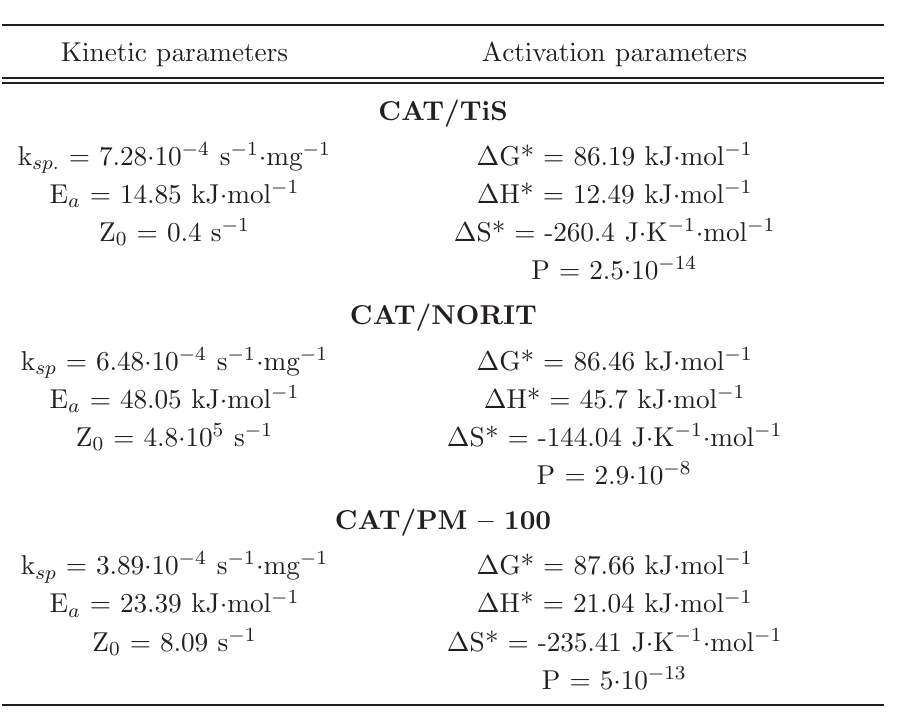
Table 2 Parameters of the bioheterogeneous systems CAT/TiS, CAT/NORIT and CAT/PM-100 in the breakdown of 3-chlorperoxibenzoic acid in